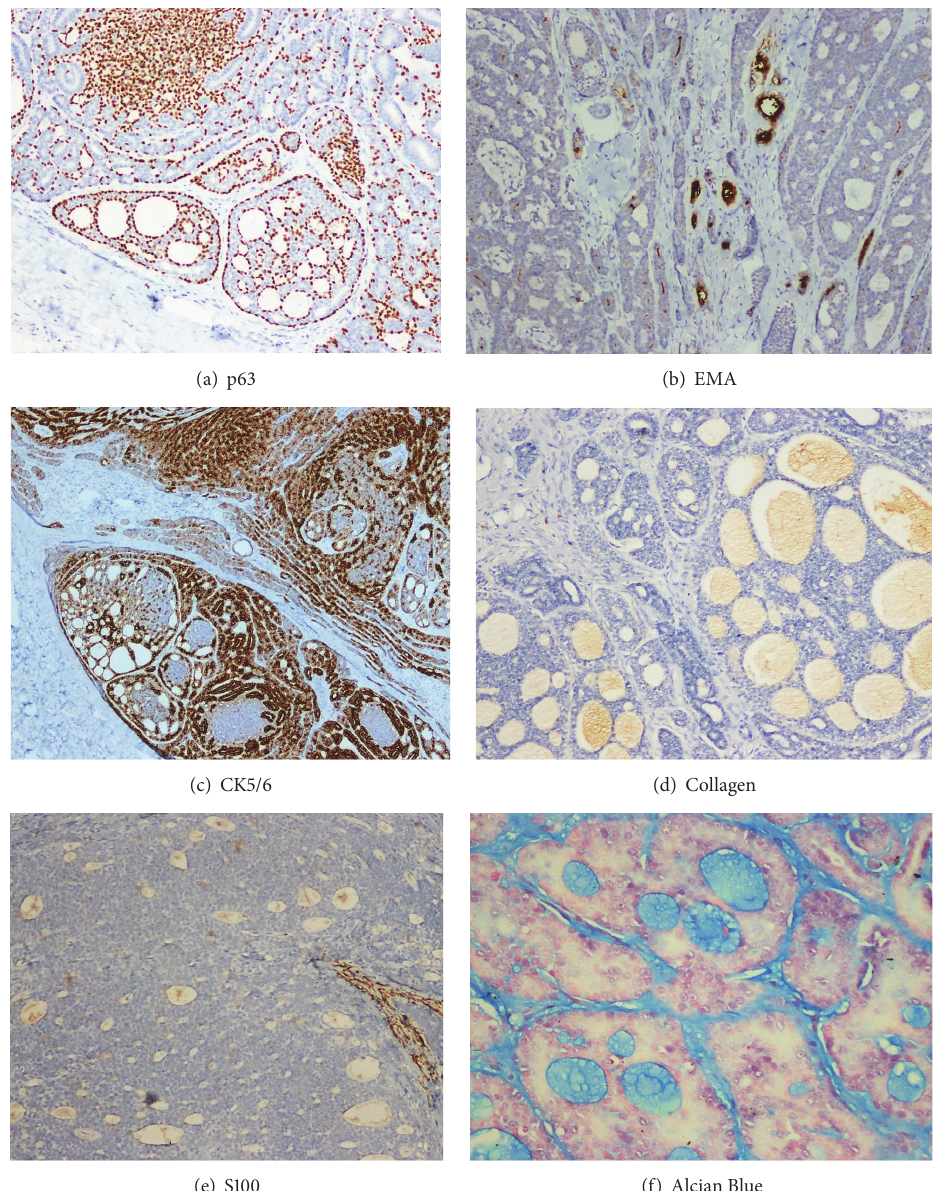
Figure 2: Primary cutaneous adenoid cystic carcinoma. (a). p63 highlights the myoepithelial cells. (b). EMA shows positivity in only a few lumina. (c). CK5/6 positivity in PCACC. (d). Although collagen 4 positivity has weak or medium intensity, it highlights the luminal material. (e). S100 is negative in our case and only positive in dendritic cells. (f). Alcian Blue positivity in luminal secretion. Original magnification: (a, b, c, e) × 100; (d) × 200; (f) ×